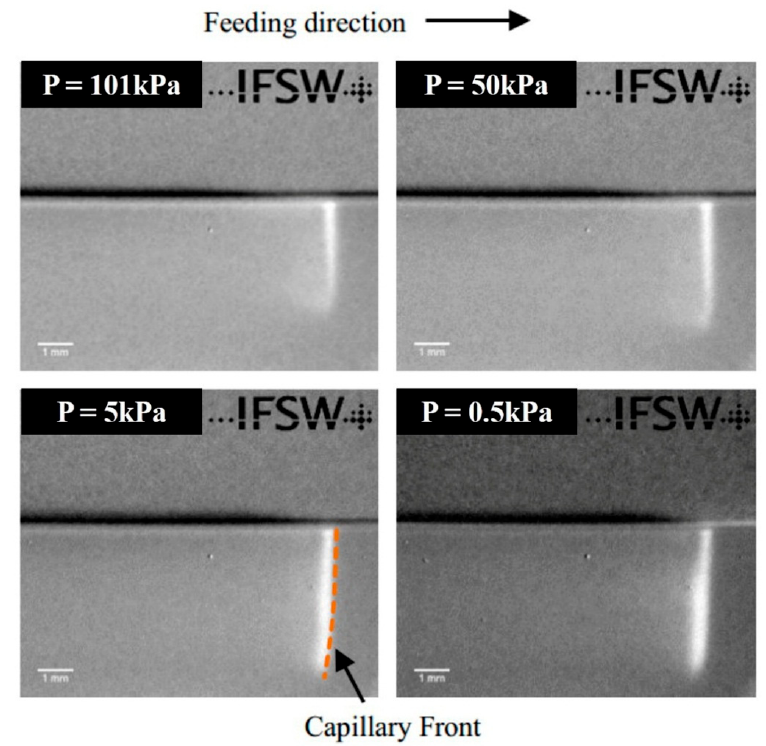
Figure 10. X-ray images of averaged keyhole shapes at ambient pressures from 0.5 kPa–101 kPa (laser power is 2 kW, welding speed is 1.2 m/min, defocus distance is 0 mm). ICALEO ® 2015 Proceedings. Reproduced with permission from [40], Laser Institute of America, 2015.